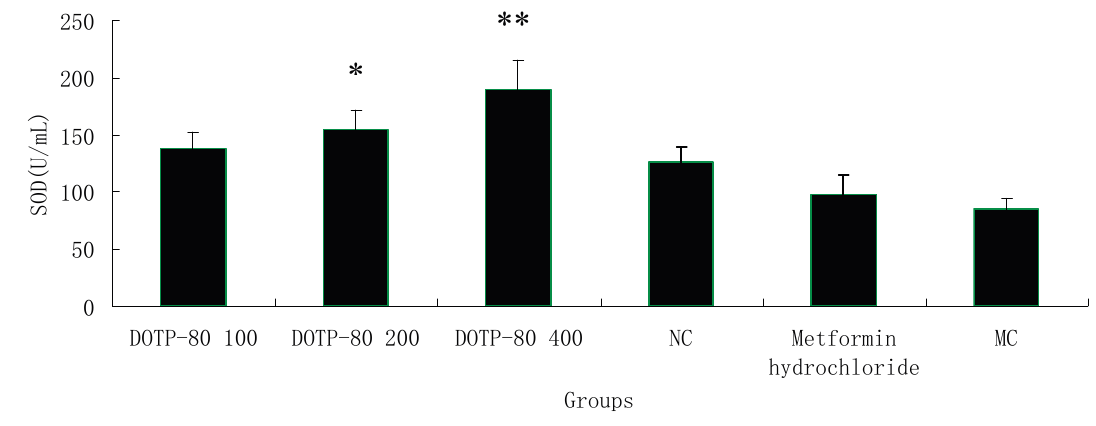
Figure 3. SOD activity. Results are presented as means ± standard deviations. * p <